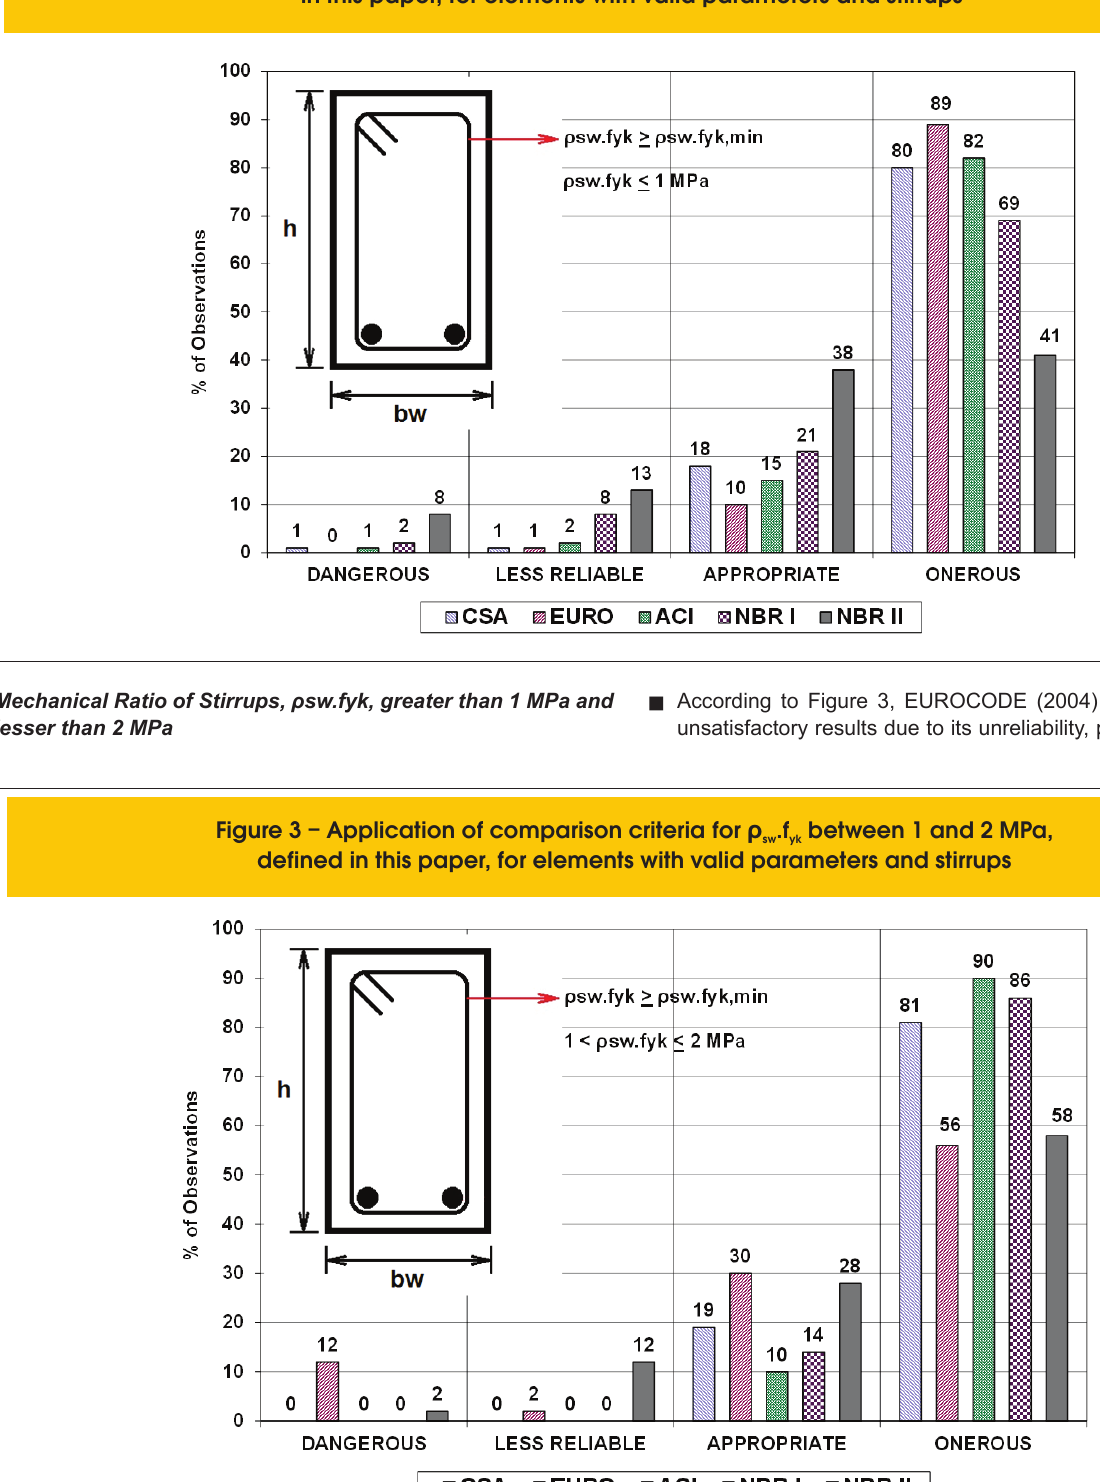
Figure 2 – Application of comparison criteria for ρ .f ≤1 MPa, defined in this paper, for elements with valid parameters and stirrups